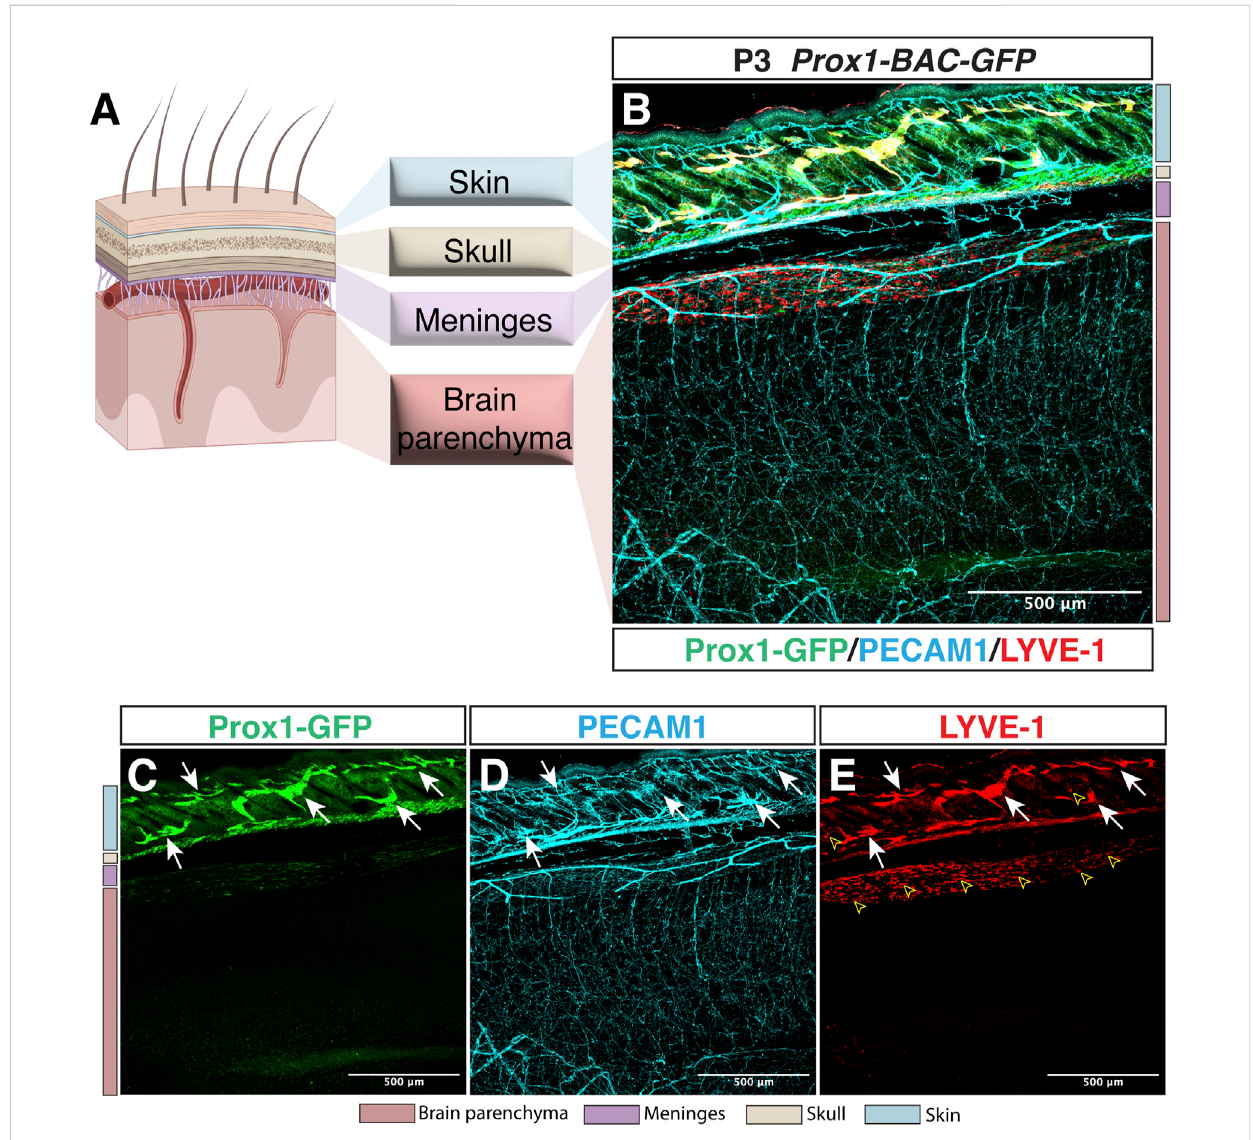
FIGURE 1 Lymphatic avascularity in the brain parenchyma. (A) Schematic representation of the brain, meningeal layers, skull bone, and skin on the left panel (Partially created with BioRender.com). (B – E) Whole-mount immunostaining of Prox1-BAC-GFP brain at postnatal day 3 (P3) is shown. Prox1-GFP labels lymphatic vessels in the skin [ (B,C) green, arrows] as well as a subset of neural progenitors (not shown) in the brain parenchyma. All the vasculature is labeled with PECAM-1 [ (B,D) cyan]. LYVE-1 labelslymphatic vessels [ (B,E) red,arrows] and macrophages(open arrowheads) intheskin as well as the pia surface of the brain. Note that no lymphatic vessels are found in the brain parenchyma. Scale bar 500 μ